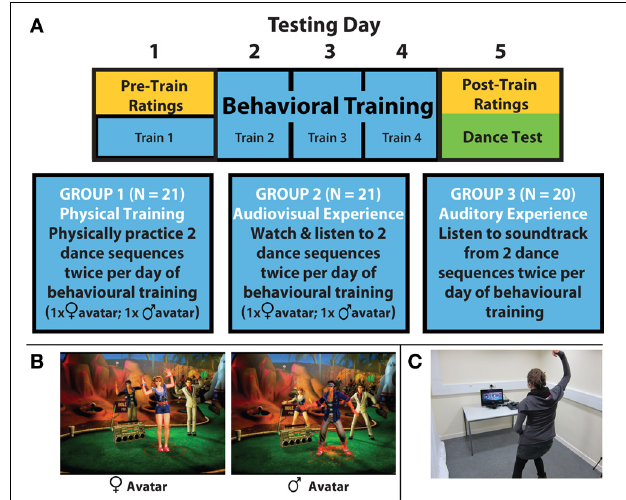
FIGURE 1 | Key elements of experimental procedures, stimuli, and apparatus. (A) Participants partook in 5 consecutive days of testing, with pre-training ratings of the stimuli collected on the first day and post-training ratings collected on the fifth and final day of testing. Participants took part in four identical training sessions (with training experience dependent on group) on days 1–4 of the experiment. Following collection of post-training ratings on day 5, participants were asked to perform the two sequences they had some kind of experience with during training, as well as one novel sequence. (B) Illustrations of the female avatar and male avatar used in the Dance Central™ video game. (C) Laboratory set up for physical training with the Xbox Kinect™ dance video